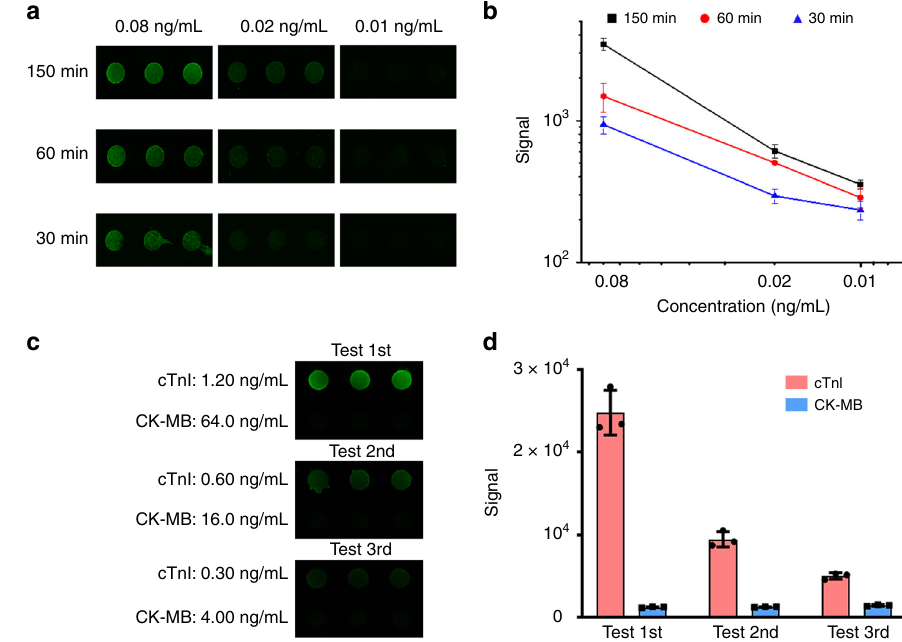
Fig. 4 Control of reaction time and cross reactivity tests. a Fluorescence mapping results and b corresponding calibration curves with the reaction time of 150, 60, and 30 min for cTnI (0.01 – 0.08 ng mL − 1 ). All experiments were conducted with n = 3; mean ± s.d. c Fluorescence images showing only one row of spots (cTnI) emitting bright fl uorescence signals when a multiplexed antibody chip (two rows, two different antibodies against biomarkers labeled at the left of the image with different concentrations) were incubated in a solution containing a mixture of the two antigens, followed by incubation in a solution containing only one of the corresponding detection antibodies without the other one. d Averaged fl uorescence intensity of each row in ( c ). All experiments were conducted with n = 3; mean ± s.d. Source data are provided as a Source Data fi le.